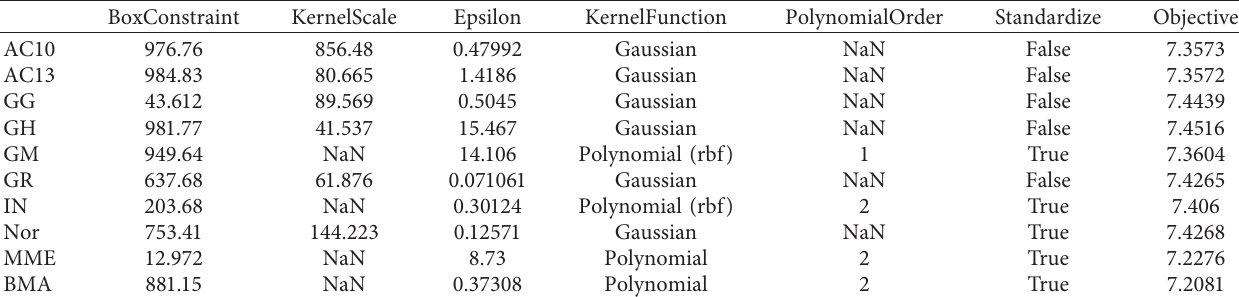
Table 9: Optimal results of Bayesian hyperparameter optimization of SVR for region mean.